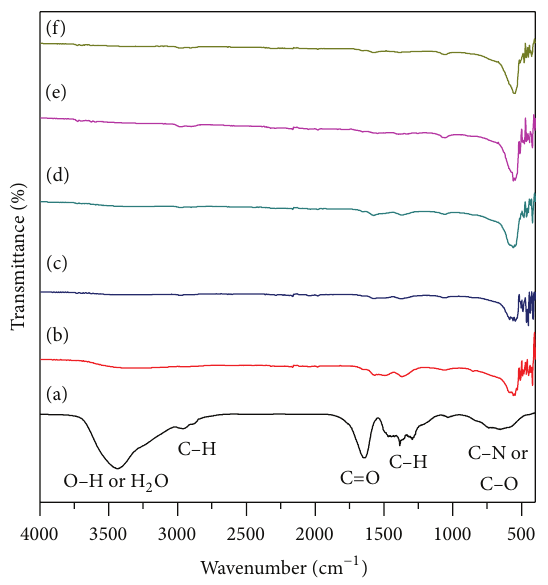
Figure 2: FTIR spectra of GDC20 before (a) and after calcination at (b) 500 ∘ C, (c) 600 ∘ C, (d) 700 ∘ C, (e) 800 ∘ C, and (f) 900 ∘ C for 8 h in